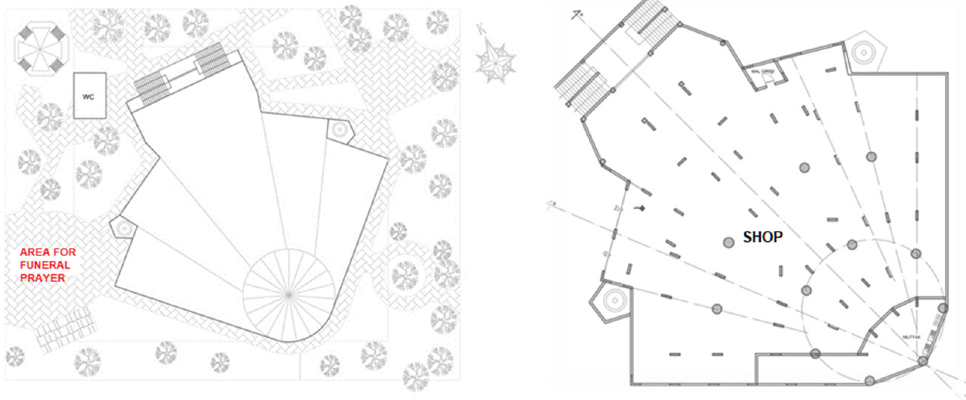
Figure 17. The Akdeniz Sanayi Mosque’s layout and ground floor plan .